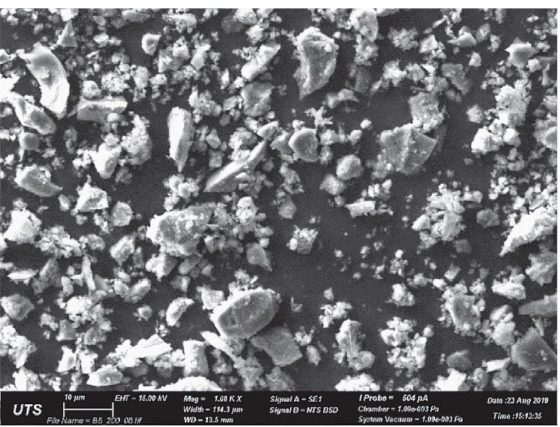
Figure 2. SEM observation of CA at 1000x magnification. Reproduced with permission from [27]. Copyright 2020,